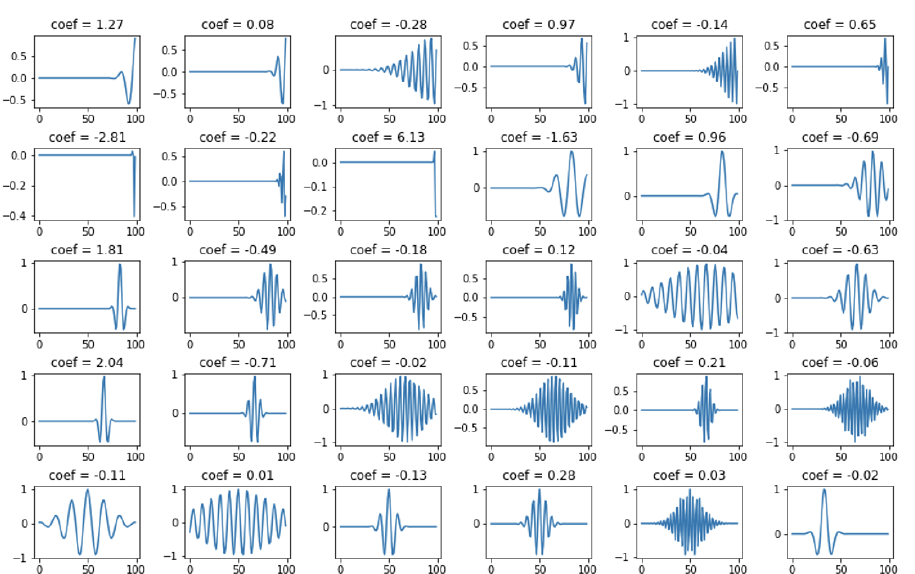
Figure 8. Atoms with non–zero coefficients, for example, signal decomposed using 30 non–zero coefficients.